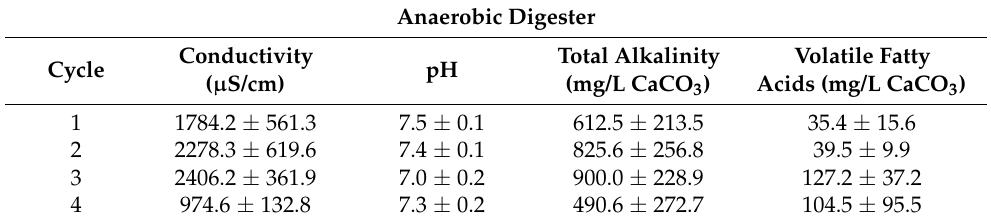
Table 3. Anaerobic digester parameters (conductivity, pH, alkalinity and volatile fatty acids).